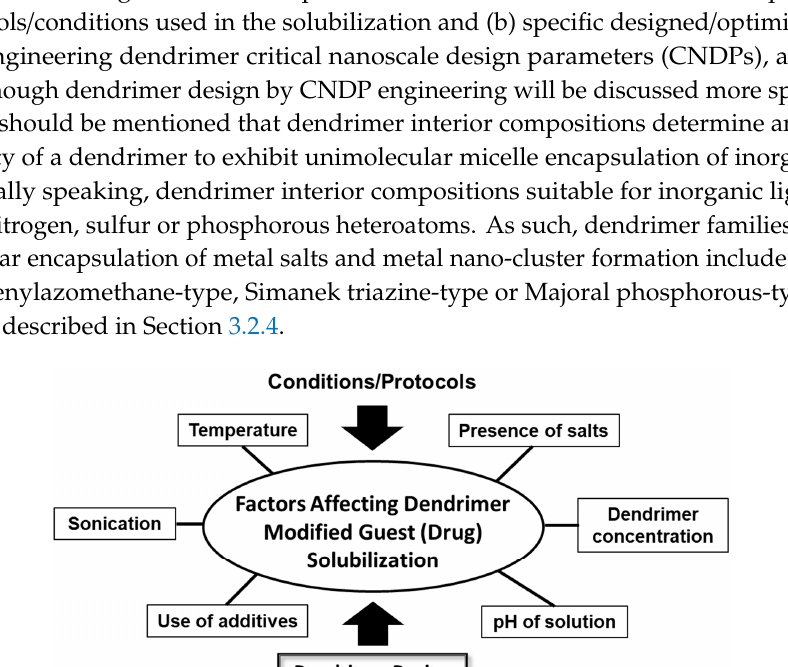
Figure 17. ( A ) Non-covalent unimolecular micelle dendrimer encapsulation, ( B ) non-covalent dendrimer aggregate encapsulation, ( C ) non-covalent dendrimer surface complexation and ( D ) covalent conjugation to the dendrimer surface. Reprinted with permission from [61]. Copyright 2001 Elsevier.